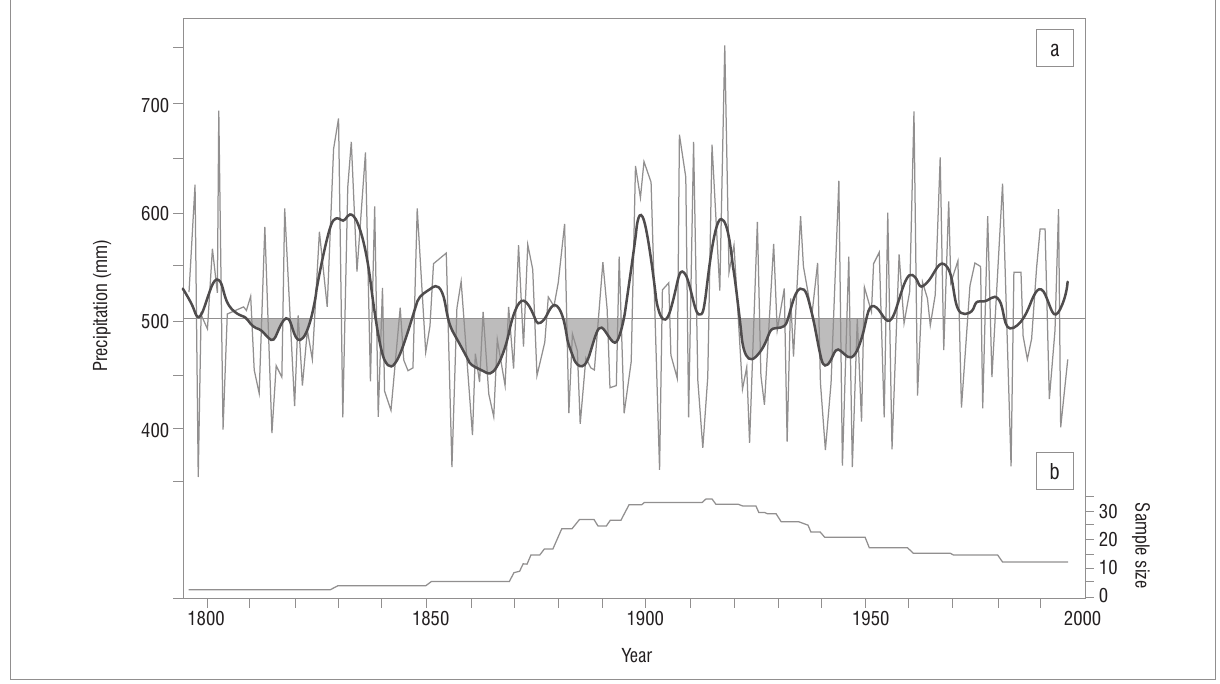
Figure 6: (a) Annual (thin line) and 10-year smoothing spline (heavy line) of reconstructed November–February regional rainfall for Zimbabwe according to tree-ring data from 1796 to 1996. (b) Sample size over time from 21 trees. The shading indicates six major decadal-length dry periods in Zimbabwe during the 19th and 20th